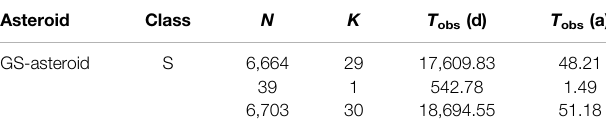
TABLE 4 | Lightcurve characteristics for the simulated Gaussian-sphere asteroid (GS-asteroid). “ Class ” denotes the Tholen taxonomical class, N and K denote the numbers of observations and lightcurves, respectively, and T obs is the time span of the observations. The uppermost numbers refer to the simulated dense ground-based observations, the ones in the middle to the simulated sparse observations, and the lowermost ones refer to the combined observations.